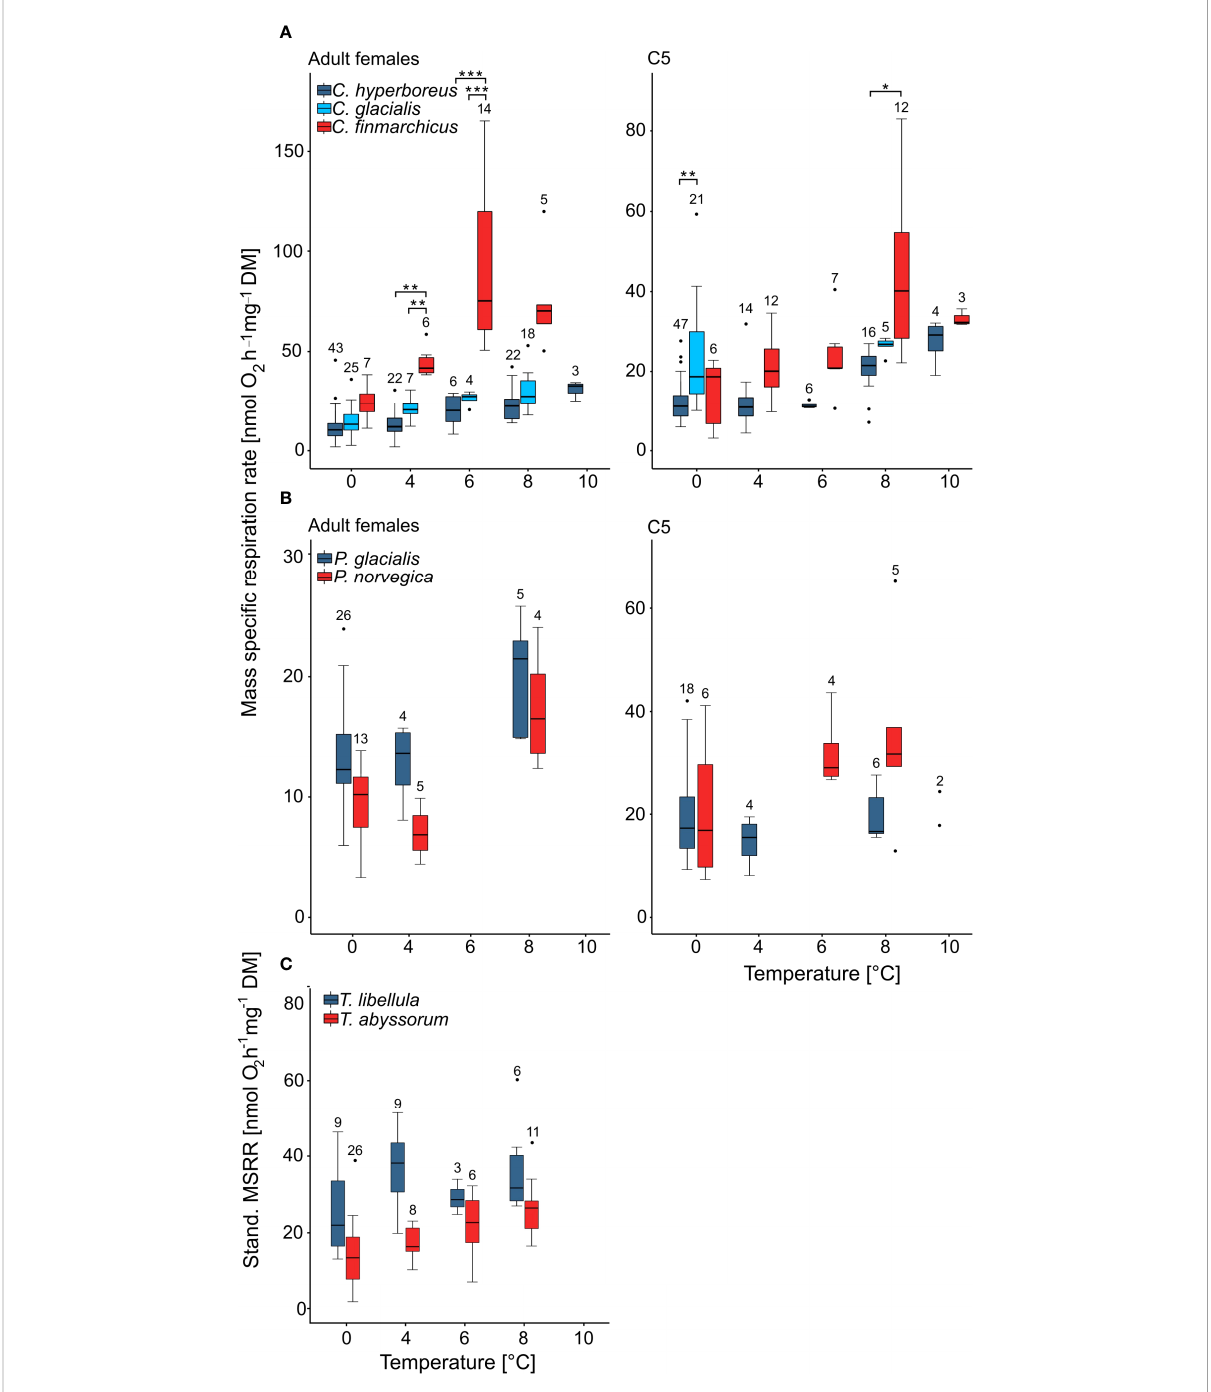
FIGURE 2 Mass-speci fi c (A, B) and standardized mass-speci fi c (C) respiration rates (Stand. MSRR) of polar-Arctic (blue) versus boreal-Atlantic (red) zooplankton species from Fram Strait. Stand. MSRR were used for Themisto species, as they had highly variable dry masses. Box represents the interquartile range (lower edge: 25 th percentile, the upper edge: 75 th percentile, central line: median, whiskers extend to minimum and maximum values within 1.5 times the interquartile range). Dots represent potential outliers that are above or below 1.5 times the interquartile range, respectively. Asterisks show signi fi cant differences in standardized respiration rates between species at the respective temperature (*p ≤ 0.05, **p ≤ 0.01, ***p ≤ 0.001). Values above the boxplots show number of measurements. (A) Calanus spp., (B) Paraeuchaeta spp., (C) Themisto